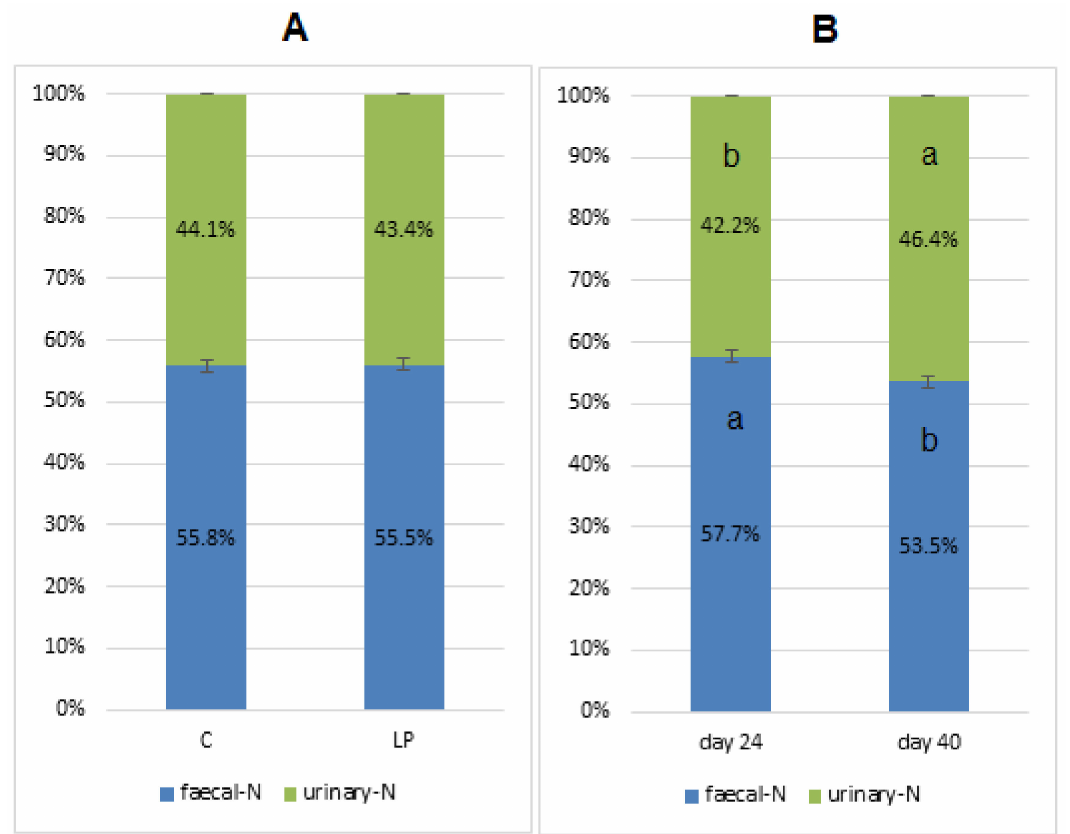
Figure 1. Effects of dietary protein content ( A ) and age of chickens ( B ) on the ratio of fecal and urinary nitrogen content of excreta. Control—commercial maize-based diet; LP—Low protein diet; SEM—standard error of the mean; a, b means with different superscripts are significantly different ( p <